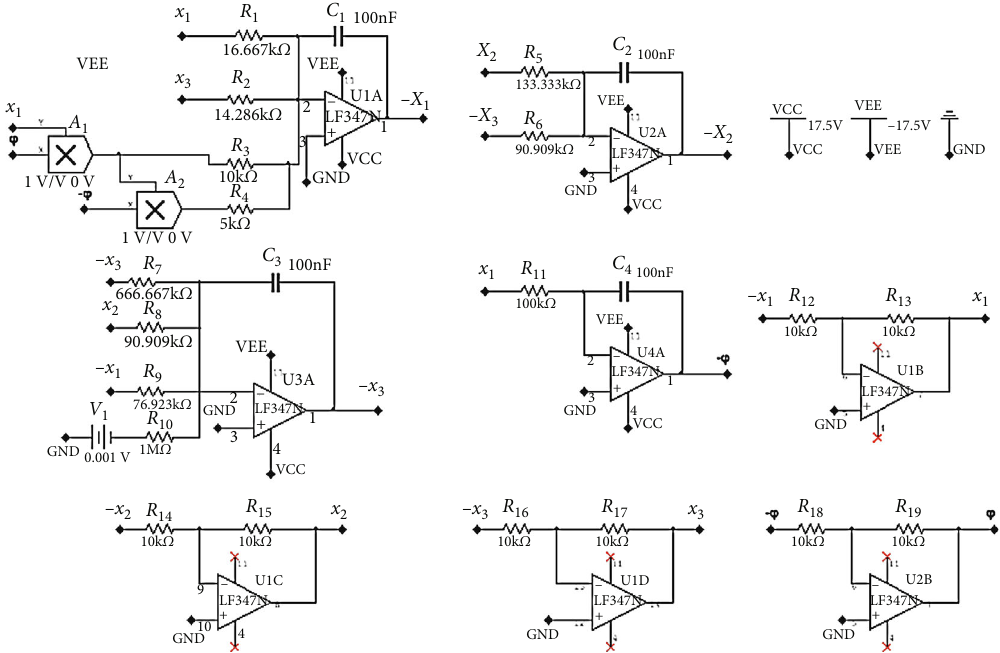
Figure 11: Equivalent circuit of the memristor-based CNN without equilibrium